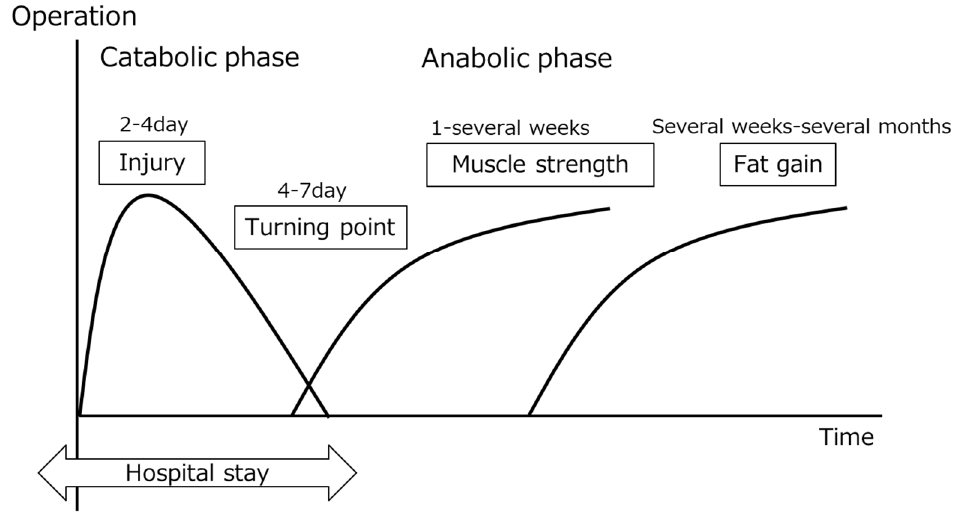
Figure 1. Metabolic changes after surgery. The metabolic state must be understood in nutritional therapy during a hospital stay.